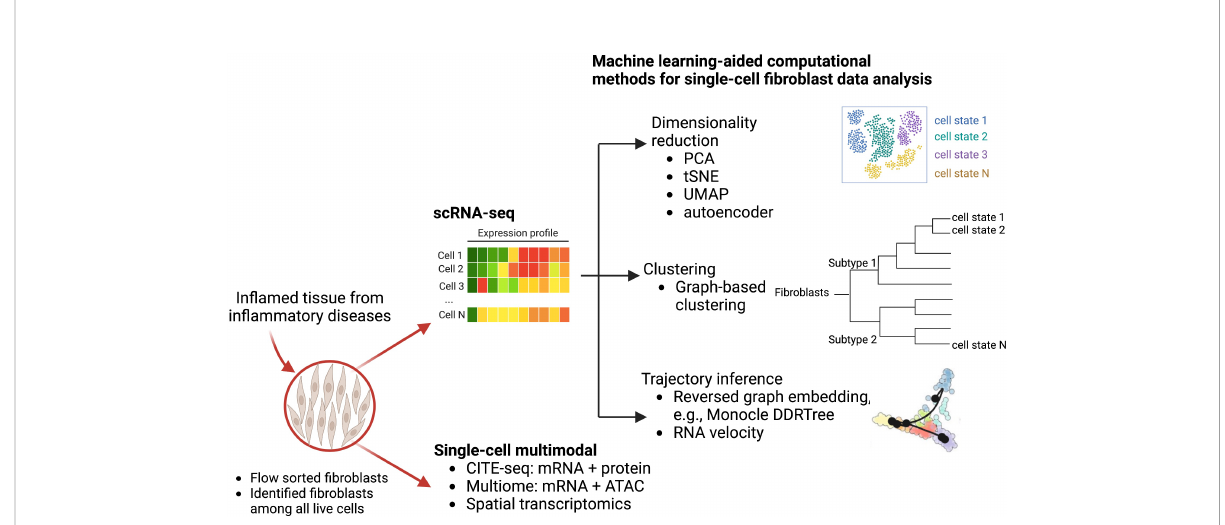
FIGURE 1 Computational machine learning algorithms that drive single-cell transcriptomics and other multimodal data analysis to study fi broblast heterogeneity. Disaggregated cells are sequenced by either multimodal technologies or scRNA-seq technologies to generate a large dataset of thousands of variables that can be modeled and analyzed via machine learning approaches. Graphical exploration of gene expression variation across cells can be done through clustering for dimensionality reduction. Continuous gene expression changes for speci fi c cell differentiation processes can be modeled with trajectory